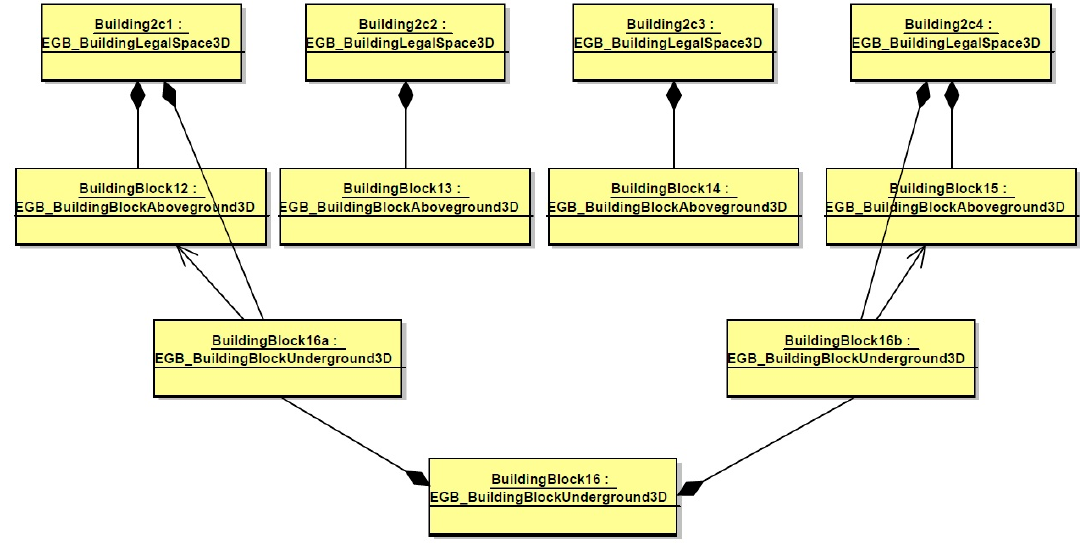
Figure 17. The UML schema of instance where the underground part is divided between two properties having access to it.